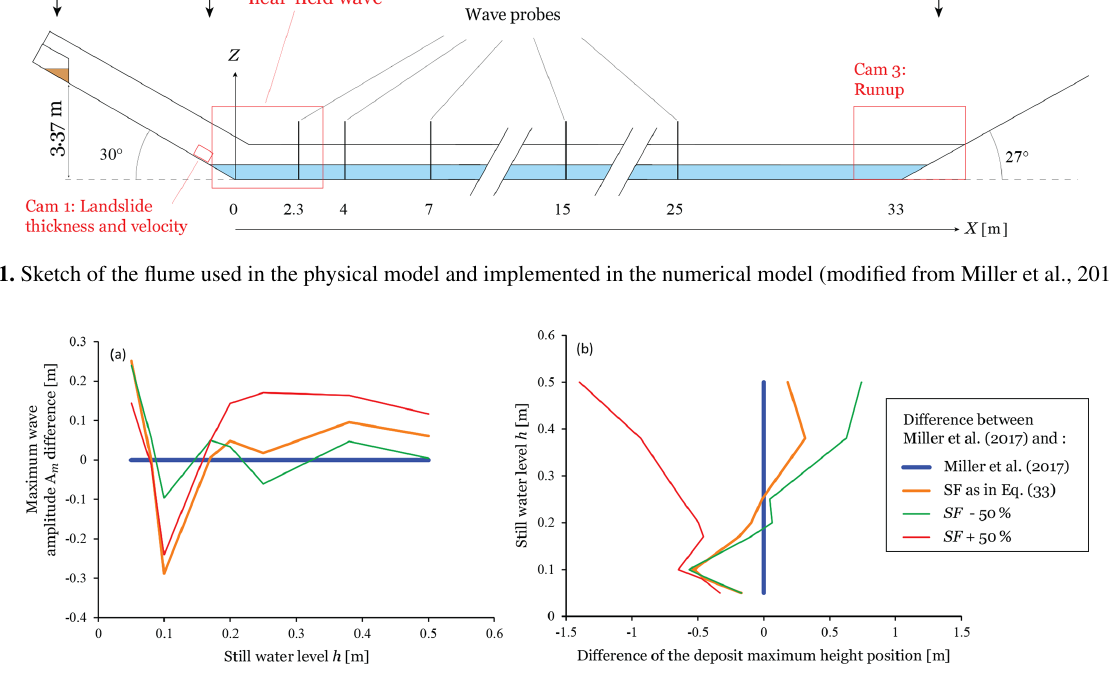
Figure 2. (a) Graph showing the difference between the A m values from Miller et al. (2017) and Miller et al. (2017) (blue line) and the A m values from the numerical simulation using different values in Eq. (33). Note that the value used in Eq. (33) (red line) is not the best-fitting curve. (b) Graph showing the difference between the positions of the apex of the landslide deposits observed in Miller et al. (2017) and Miller et al. (2017) (blue line) and the positions obtained from the numerical